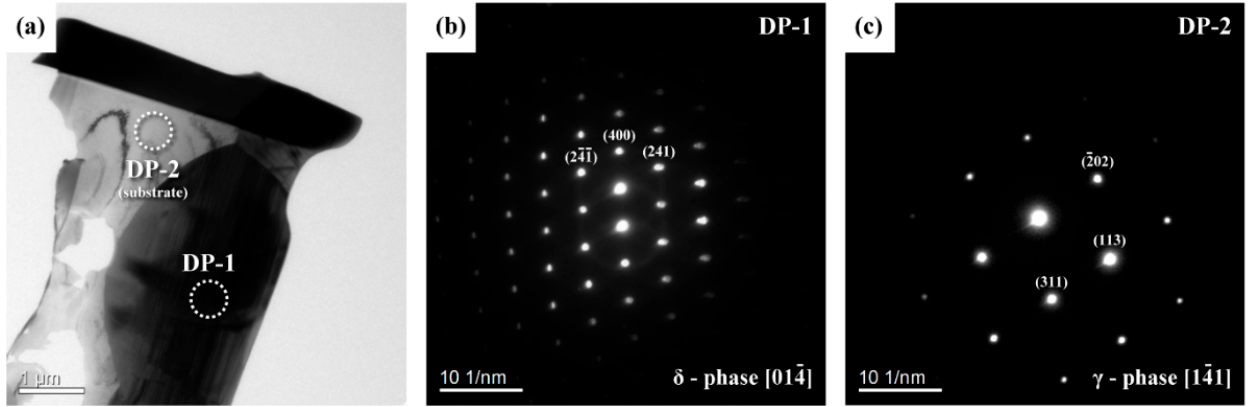
Figure 7. ( a ) Bright field TEM image of the FIB sample and the SADP of the ( b ) δ -phase and ( c ) substrate. ( c )